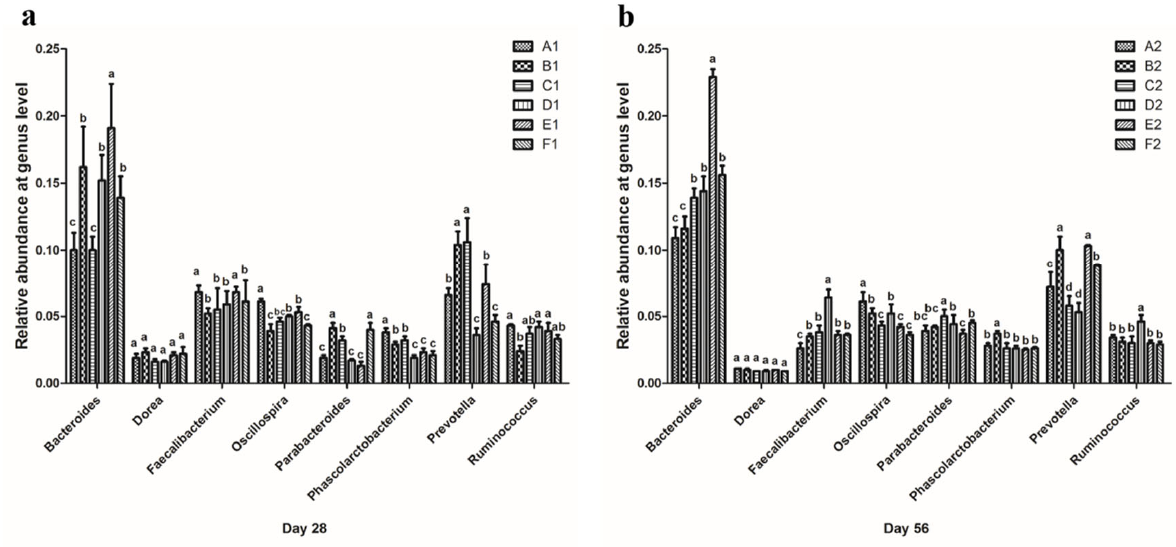
Figure 5. Effects of different additions of MOLP on relative abundance of ( a ) the most dominant genus ( ≥ 1%) on day 28 and ( b ) the most dominant genus ( ≥ 1%) on day 56 in the cecum microflora of broiler chickens. The error bars represent the SEM of three samples, and the results are described as mean ± SEM. Statistical analysis of the data was performed by using Duncan’s method to analyze the significance of differences between samples by using IBM SPSS software. Means with similar superscripts in the same column indicate that there are no significant differences ( p > 0.05), and those with different superscripts in the same column indicate significant differences ( p < 0.05).